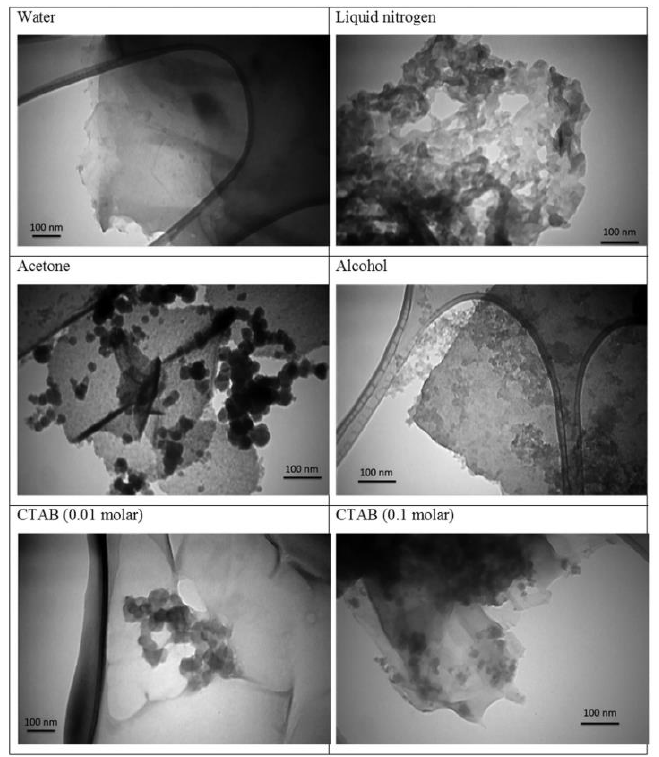
Figure 17. The effect of liquid medium on the formation of GNS. Reprinted with permission from Ref. [85]. 2019, Laser Institute of America.